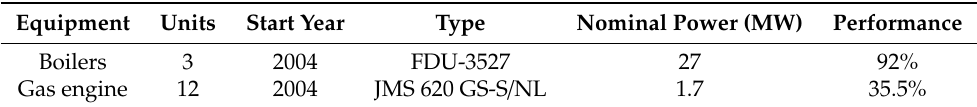
Table 4. E ffi ciencies of each type of equipment.